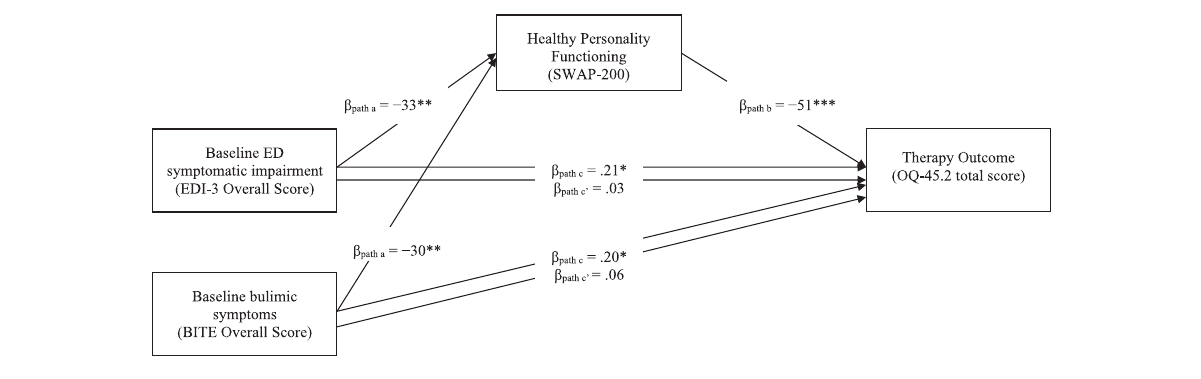
FIGURE 1 | Mediation Model with SWAP-200 Healthy Personality Functioning as a Mediator of the Effect of Bulimic and Overall Eating Symptoms at Intake on Therapy Outcome ( N = 107). EDI-3 = Eating Disorder Inventory-3 (Garner, 2004); SWAP-200 = Shedler-Westen Assessment Procedure-200 Healthy Personality Functioning Scale (Westen and Shedler, 1999a,b); BITE = Bulimic Investigatory Test, Edinburgh (BITE; Orlandi et al., 2005); OQ-45.2 = Outcome Questionnaire-45.2 total score (Lambert et al., 2010). Confidence intervals computed using bootstrap percentiles.